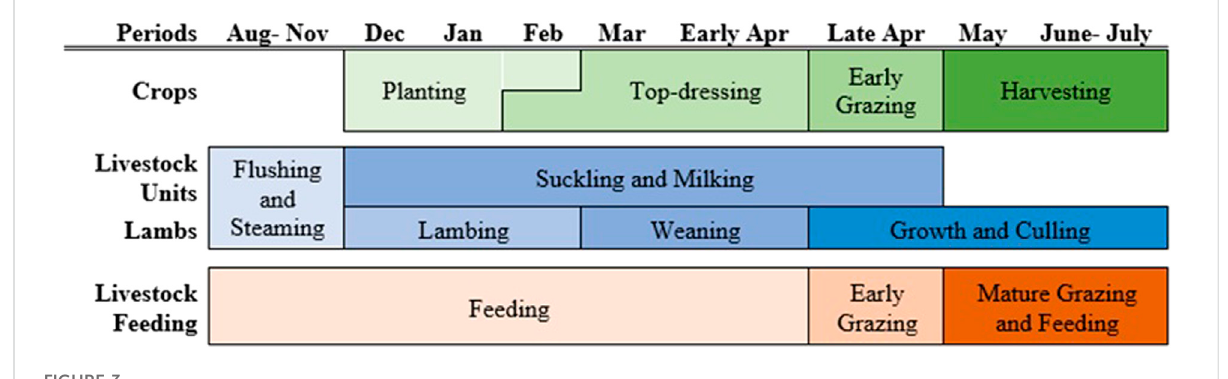
FIGURE 3 The timimg of decisions of the integrated